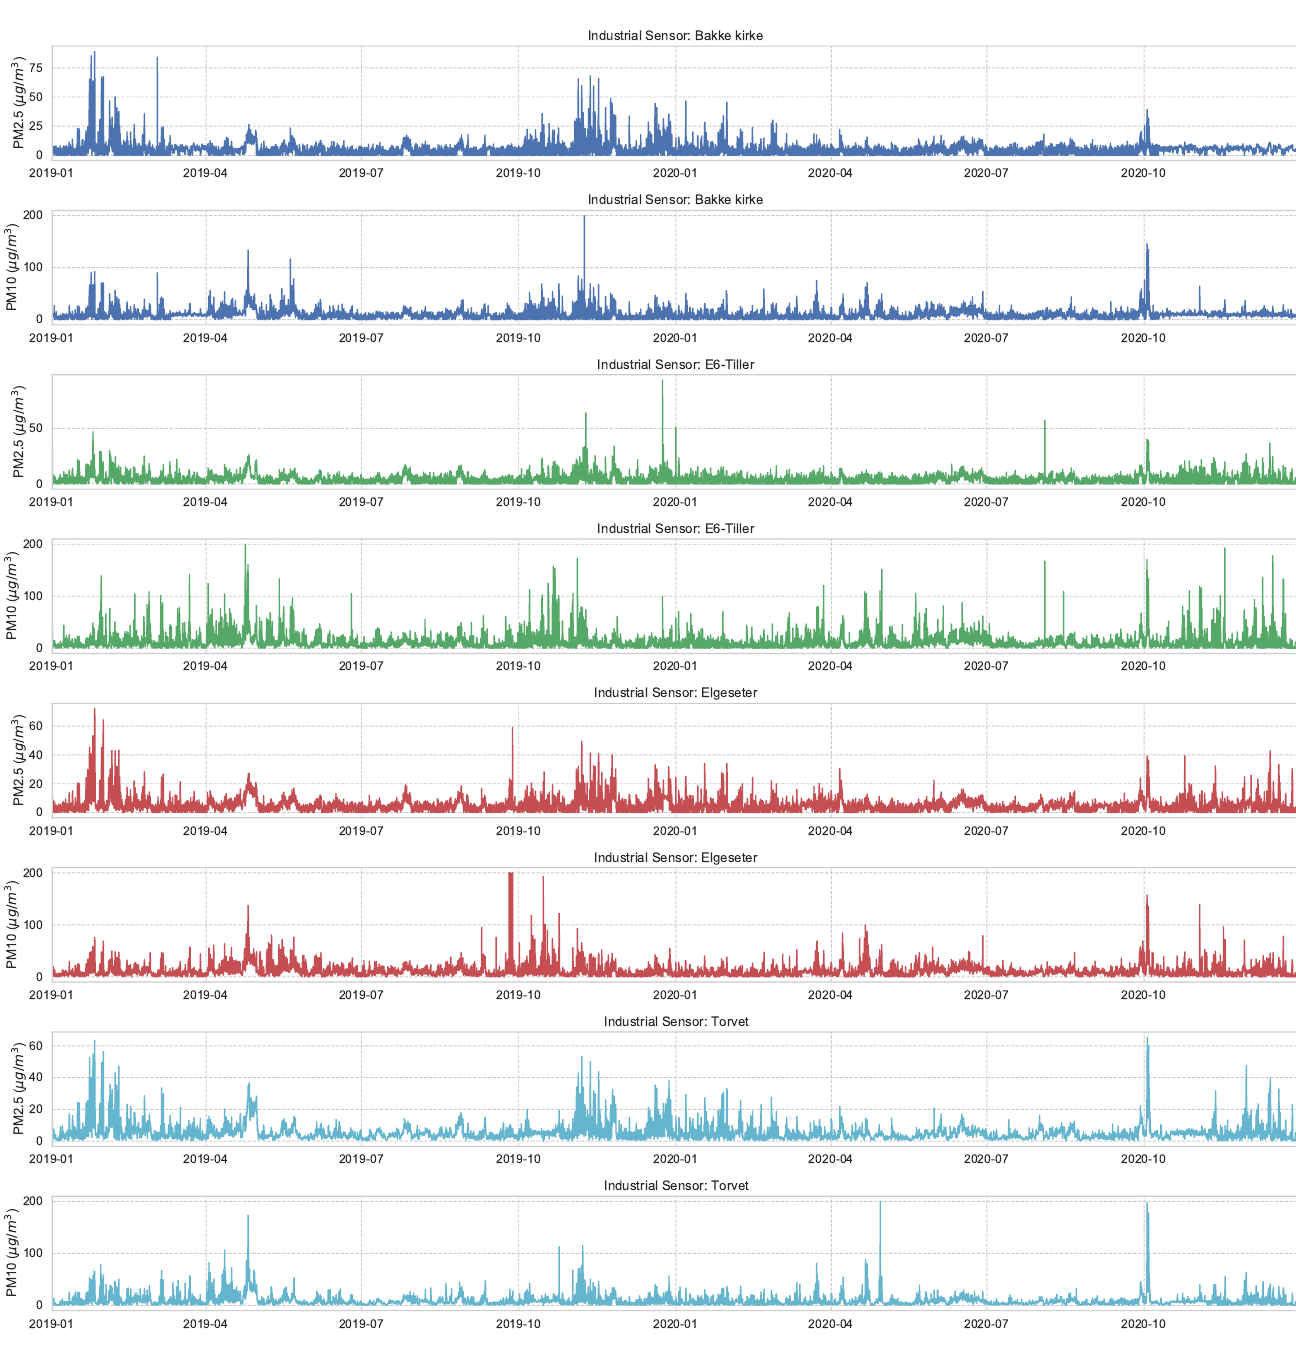
Figure A1. Air quality data of PM 2.5 and PM 10 , measured over two years in four different sensing stations in the city of Trondheim. These data are offered by the Norwegian Institute for Air Research (NILU) (https://www.nilu.com/open-data/, accessed on 27 November